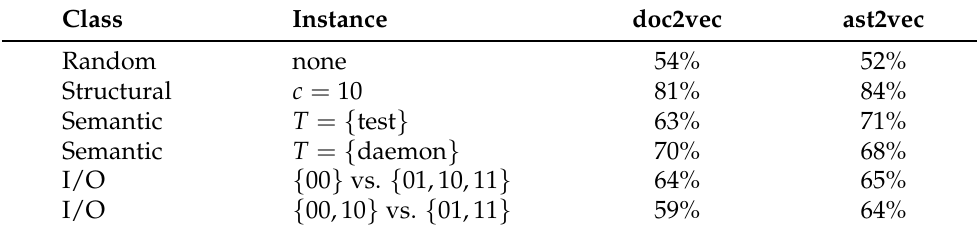
Table 1. Best accuracy score for each of the problems defined in Section